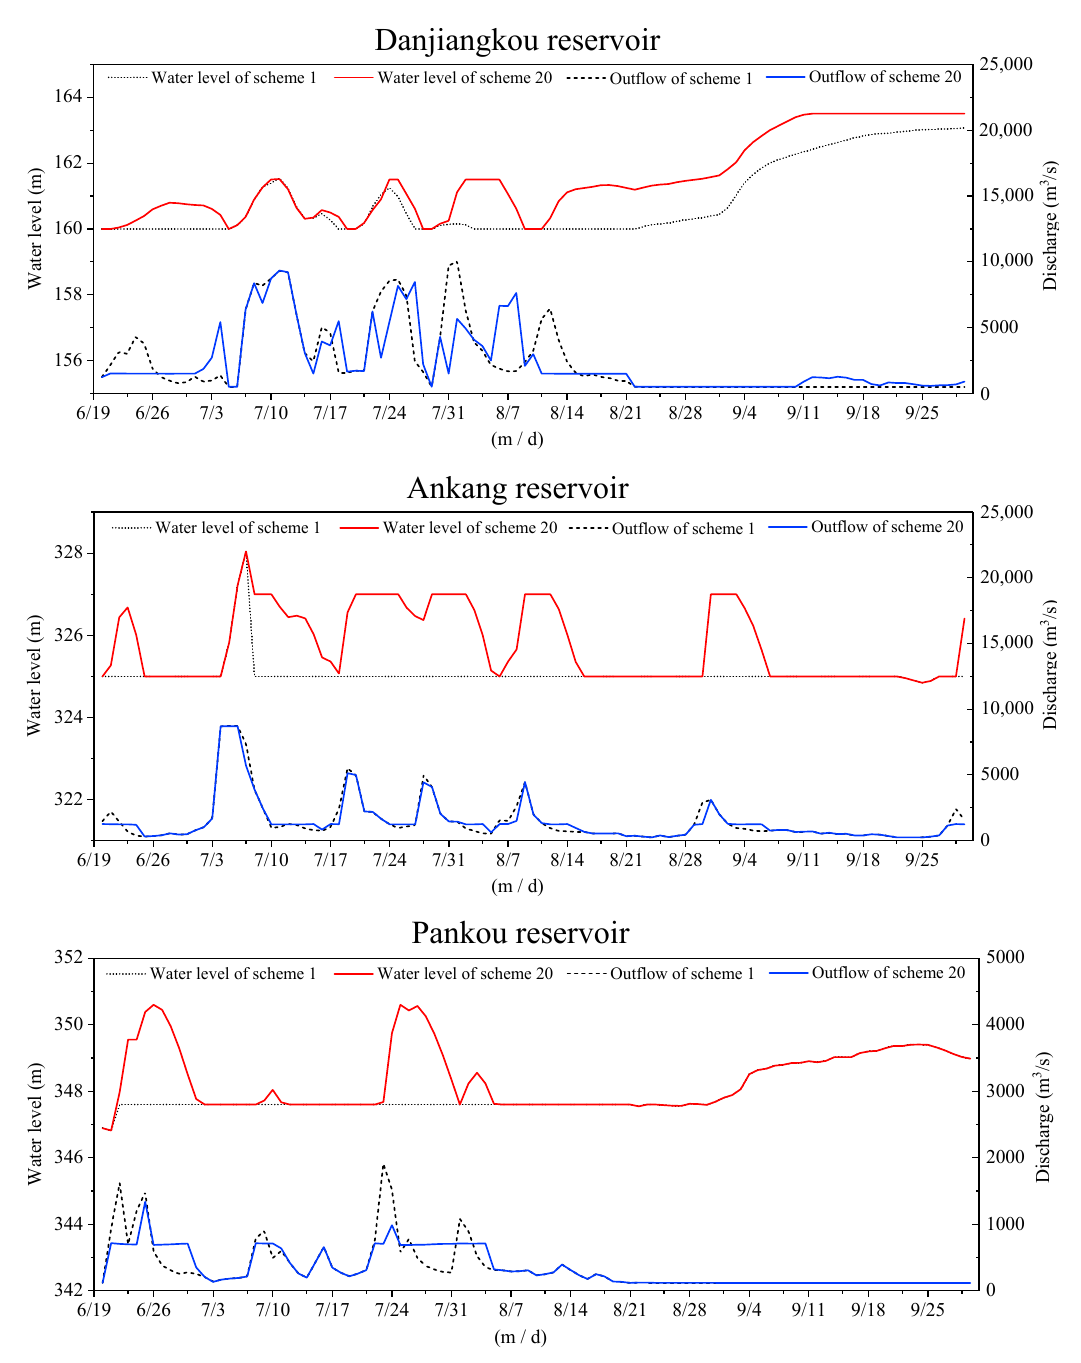
Figure 5. Comparison of operation process between scheme 1 and scheme 20 in a normal year.